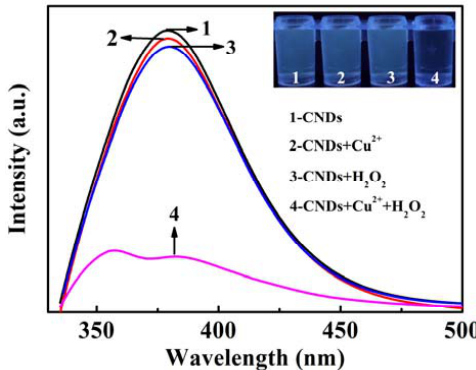
Figure 2. Fluorescence spectra of CNDs in the absence and presence of Cu 2+ , H 2 O 2 , and the mixture of Cu 2+ and H 2 O 2 , respectively. The concentrations of CNDs, Cu 2+ , and H 2 O 2 were 0.014 mg/mL, 2 μ M, and 5 mM, respectively.